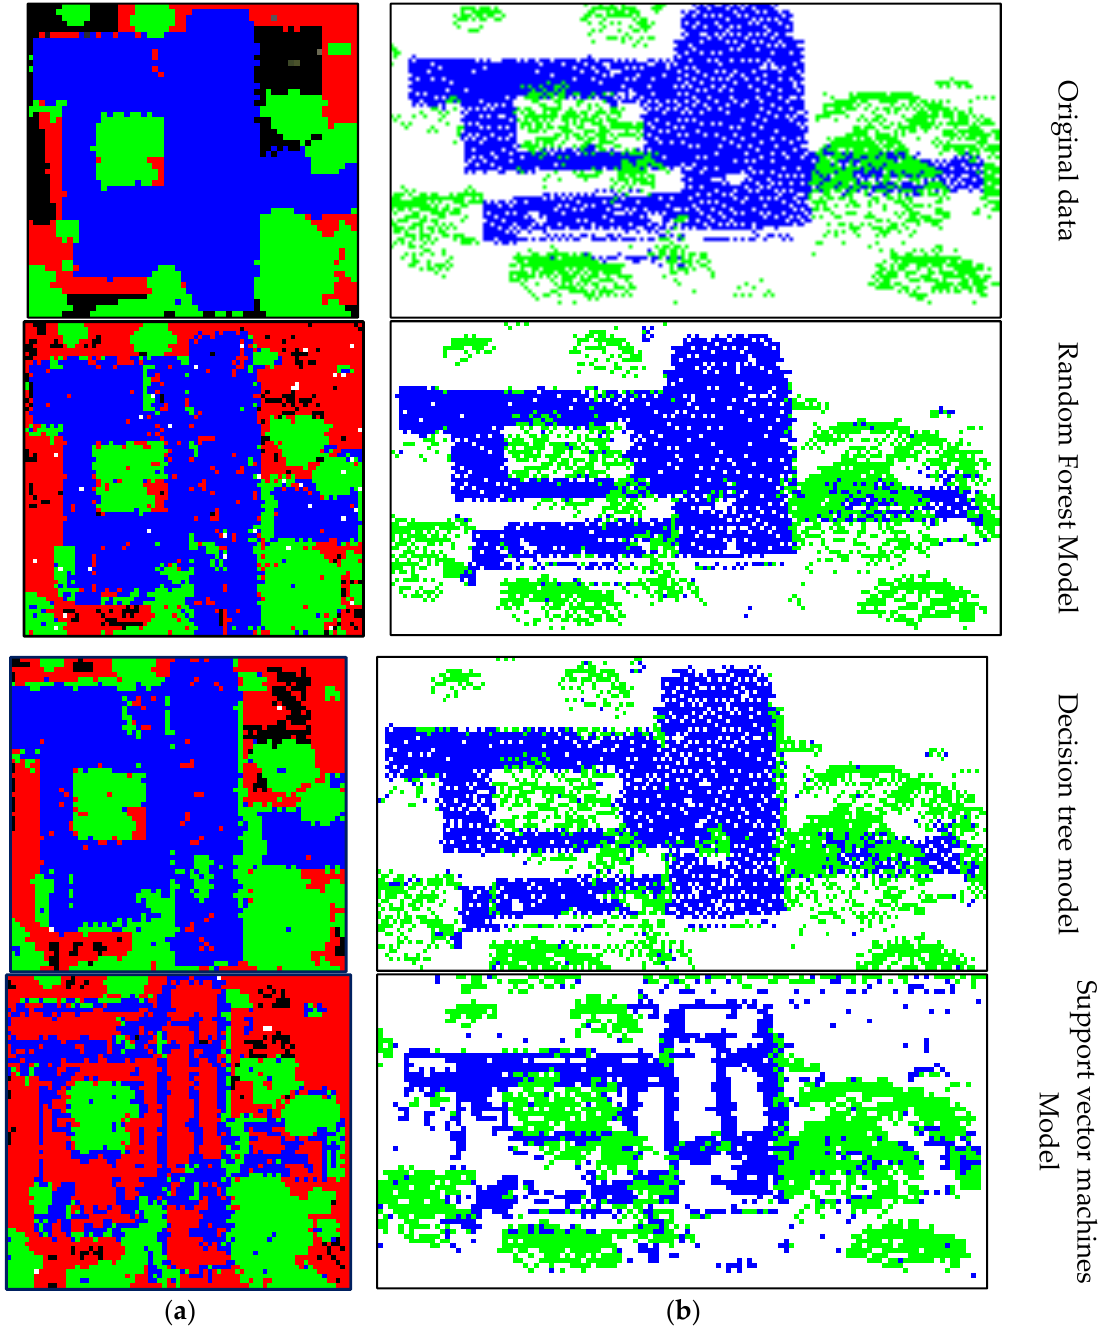
Figure 8. Point cloud classification results of experimental area S_1. ( a ) Top view. ( b ) Side view (buildings and trees).